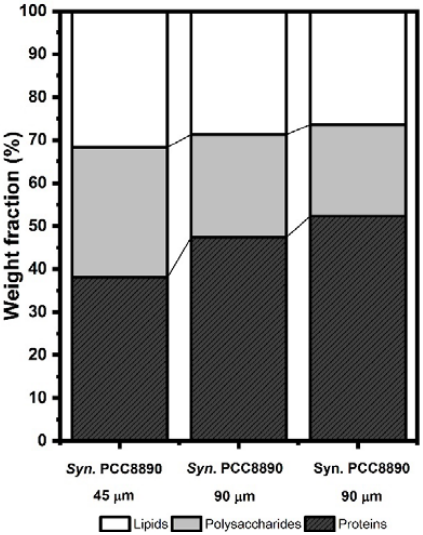
Figure 2. Weight fractions of the predominant macromolecules in the Synechococcus cell envelope. Calculation made from XPS-measured ratios of N/C and O/C. XPS spectra of Synechococcus strains at the different P concentrations for the C1s, O1s, and N1s regions are shown in Supplementary Information, Figure S6.